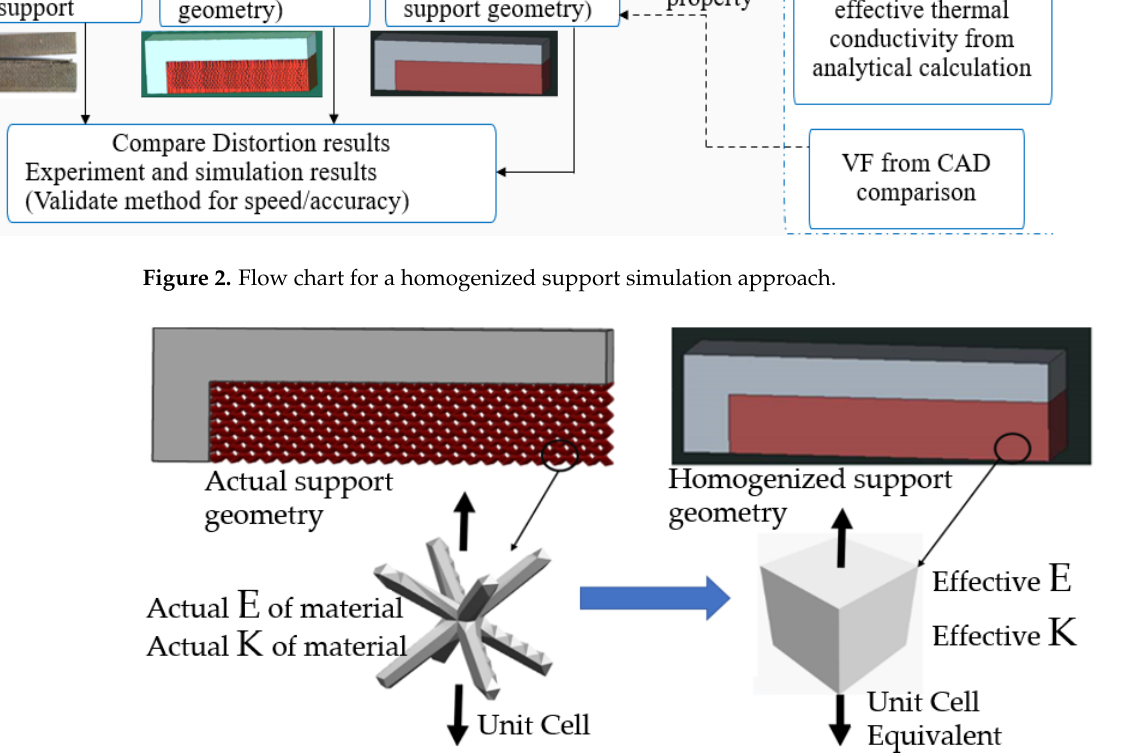
Figure 3. Replacing lattice support geometry with homogenized block support.